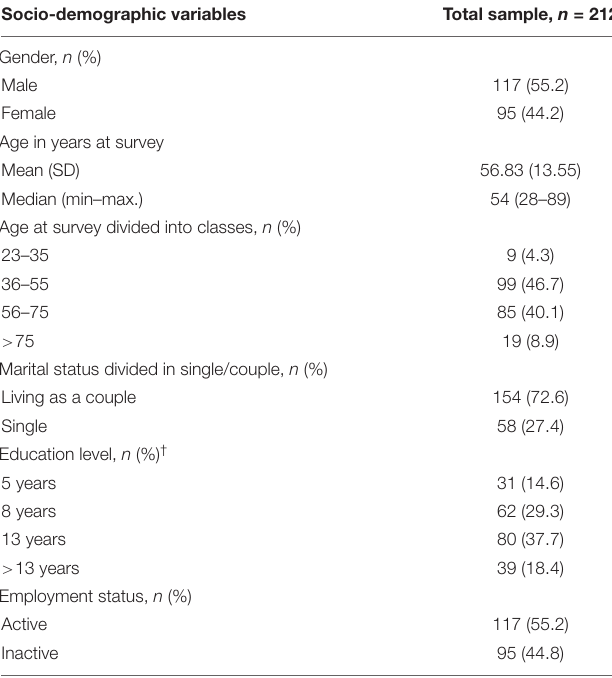
TABLE 1 | Socio-demographic